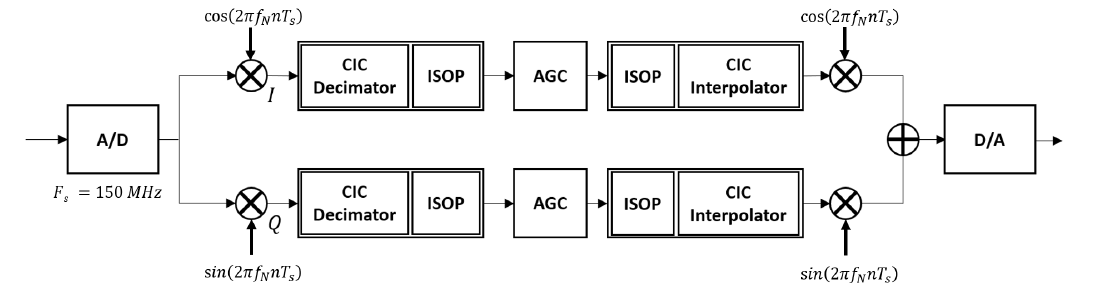
Figure 3. Block diagram of FM digital-signal-processing algorithm.